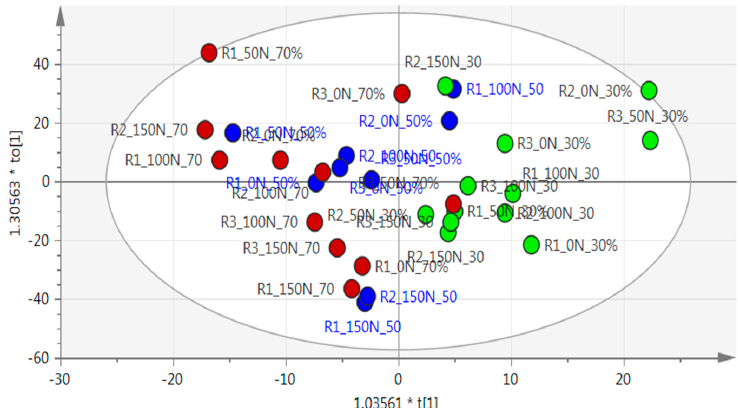
Figure 2. Orthogonal partial least square discriminatory analysis (OPLS-DA) results of Pelargonium sidoides on nuclear magnetic resonance (NMR) spectra, with the ellipse representing hoteling within 95% confidence. The well-watered treatment (30% allowable depletion level (ADL)) is represented by green dots, moderately stressed (50% ADL) by blue dots, and severely stressed (70% ADL) by red dots. R 2 X = 0.766 and Q 2 =